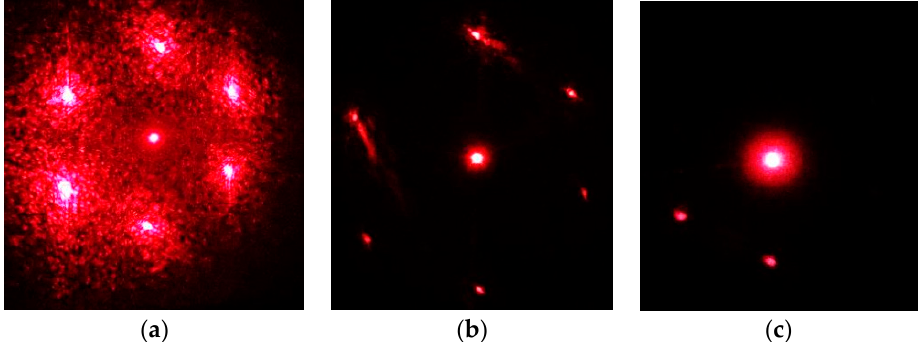
Figure 12. Retroreflected outputs by ( a ) anterior, ( b ) central, and ( c ) posterior region of the commercial CCCR.